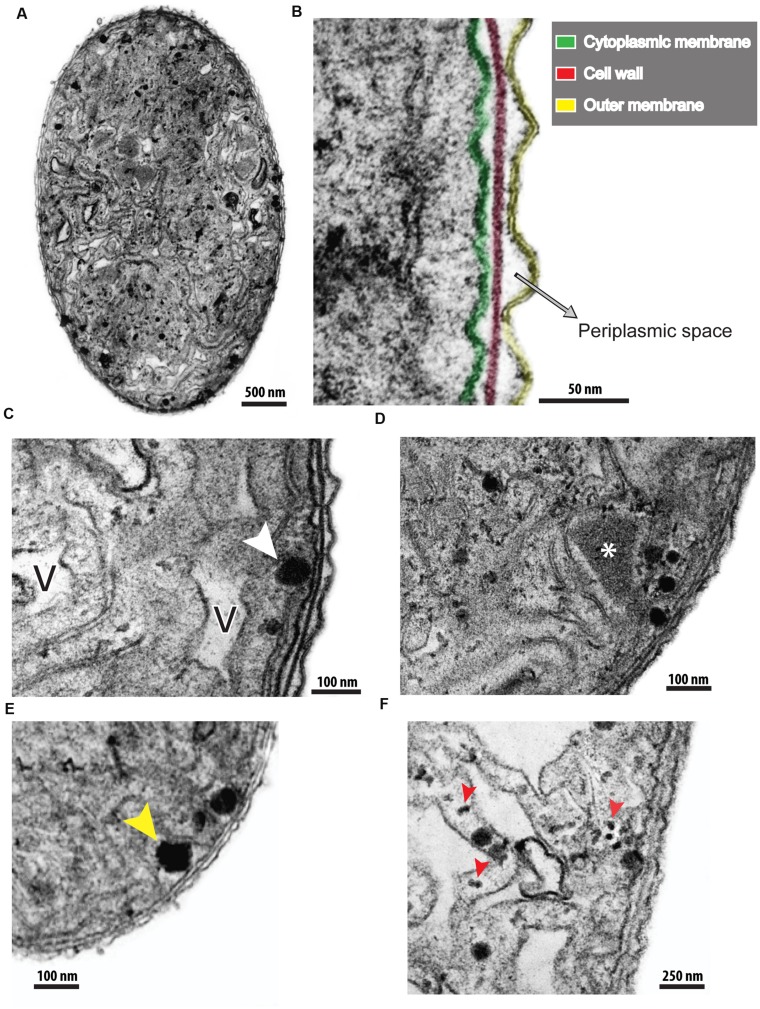
Different views of untreated C. raciborskii cells observed by transmission electron microscopy (TEM). In (A), a cross-section of a cell shows a general view of the cytoplasm, cell envelope and their organization. (B) At higher magnification, the structure of the cellular envelope is more clearly revealed. Note the cytoplasmic membrane (green), cell wall (red) and outer membrane (yellow). (C–E) Cytoplasmic structures such as air vesicles (V), lipid bodies (white arrowhead), polyhedral bodies (∗), and polyphosphate granules (yellow arrowhead) are observed. In (F), the thylakoid membrane structure is seen at high magnification. Phycobilisomes (red arrowheads) are viewed as small electron-dense dots in association with thylakoid membranes.